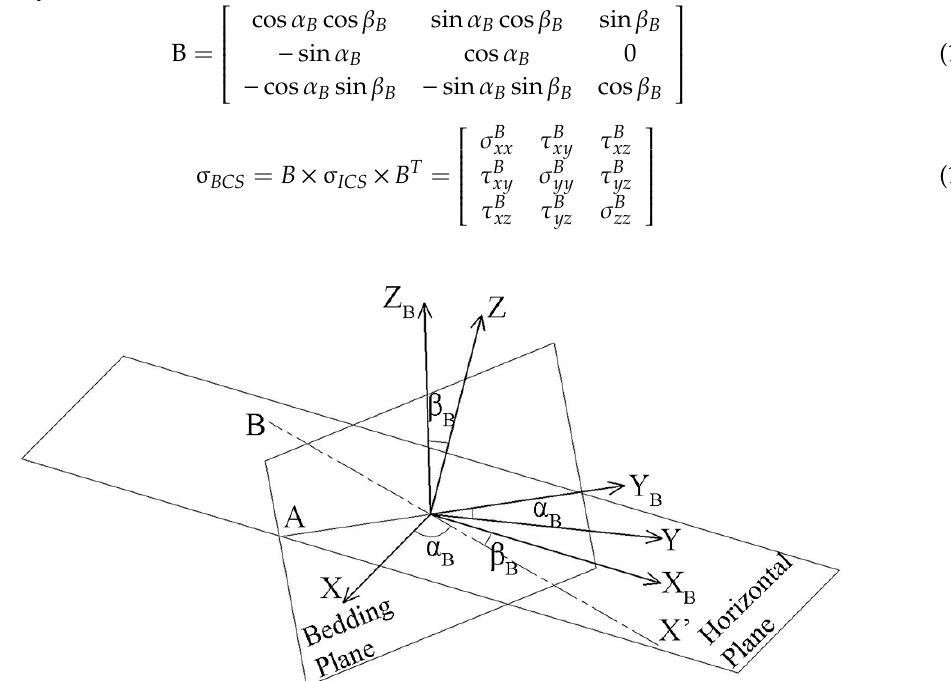
Figure 4. Relationship between the bedding plane and in-situ stress coordinate systems.